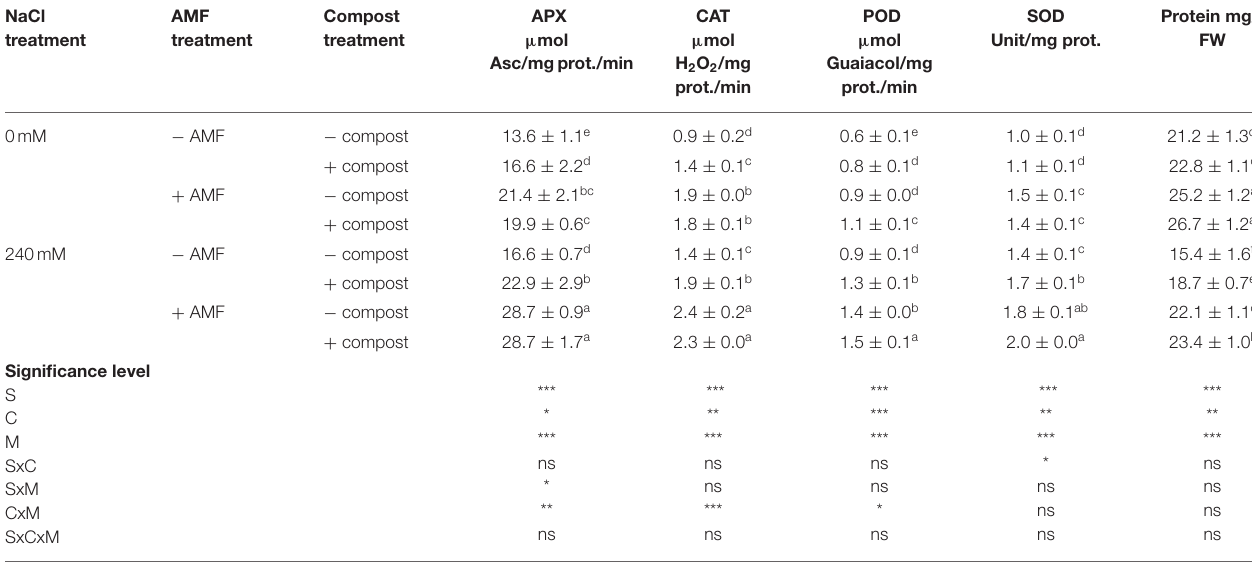
*** significant at P <